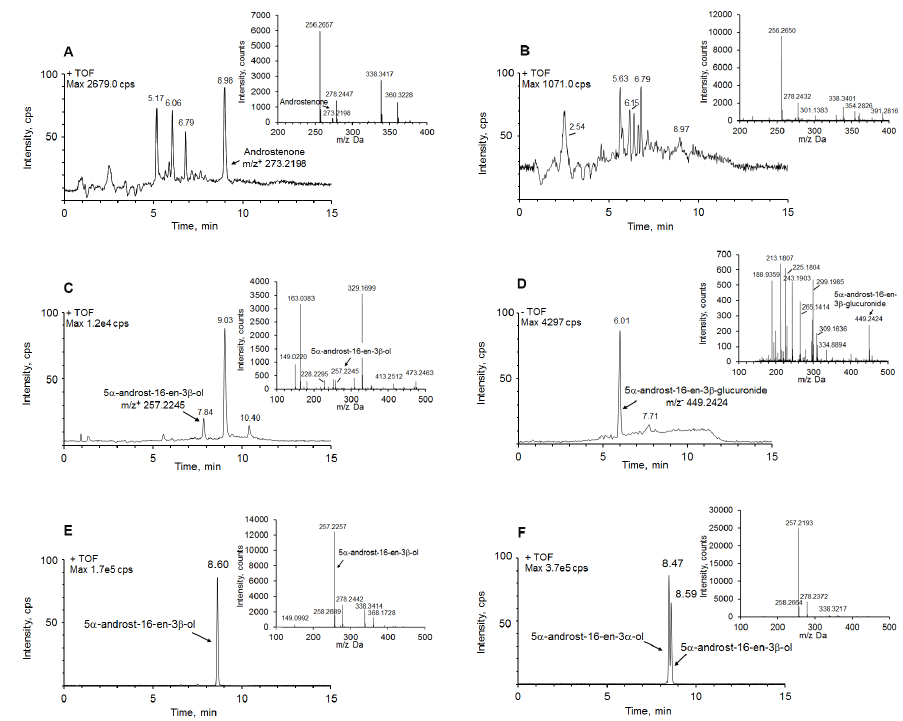
Figure 1. Ion chromatograms and mass spectra (inset) of androstenone and its metabolites. ( A ) androstenone in the medium in absence of isolated hepatocytes; ( B ) androstenone in the medium in the presence of isolated hepatocytes. No androstenone was found after 24 h of cell culture; ( C ) identified androstenone metabolite (m/z + =257.2245). The samples were analyzed in ESI + ionization mode; ( D ) identified androstenone metabolite 5 a -androst-16-en-3 b -glucuronide (m/z 2 =449.2424) in ESI– ionization mode; ( E ) identified androstenone metabolite 5 a -androst-16-en- 3 b -ol after enzyme hydrolysis by b -glucuronidase; ( F ) a mixture of authentic standards 5 a -androst-16-en-3 a -ol (3 a -A) and 5 a -androst-16-en-3 b -ol (3 b - A).